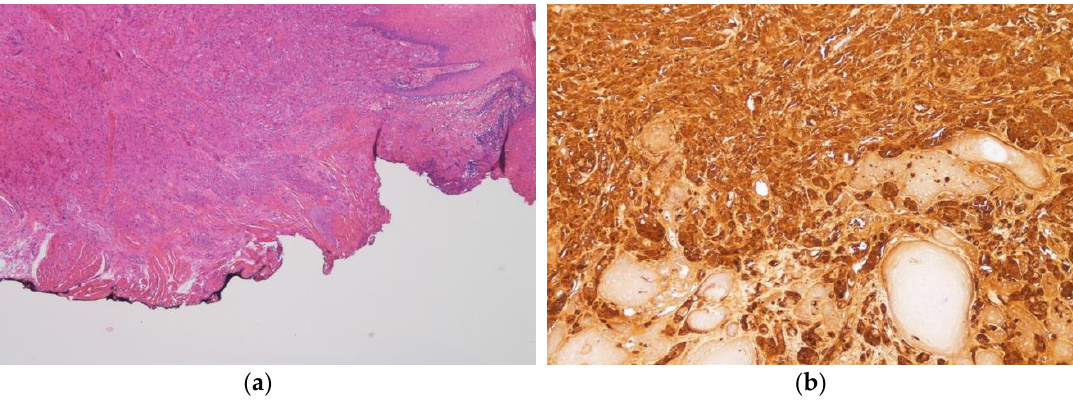
Figure 2. ( a ) Histopathological features of granular cell tumor. The massive presence of granular cells (H&E staining; 10× magnification). ( b ) Immunohistochemical staining for S-100 protein. Strong positivity (40× magnification).